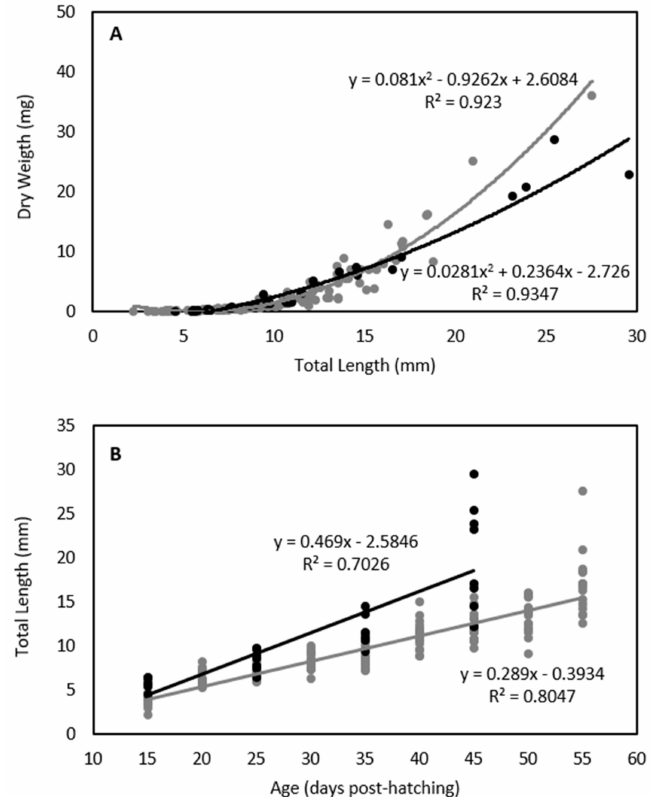
Figure 2. Relationship between total length (mm) and dry weight (mg) (n = 175) ( A ), and between age (days post-hatching) and total length (mm) (n = 175) ( B ) for white seabream Diplodus sargus (Linnaeus, 1758) larvae tested for critical swimming speed (black) and endurance (grey) along ontogeny (15, 20, 25, 30, 35, 40, 45, 50, and 55 days